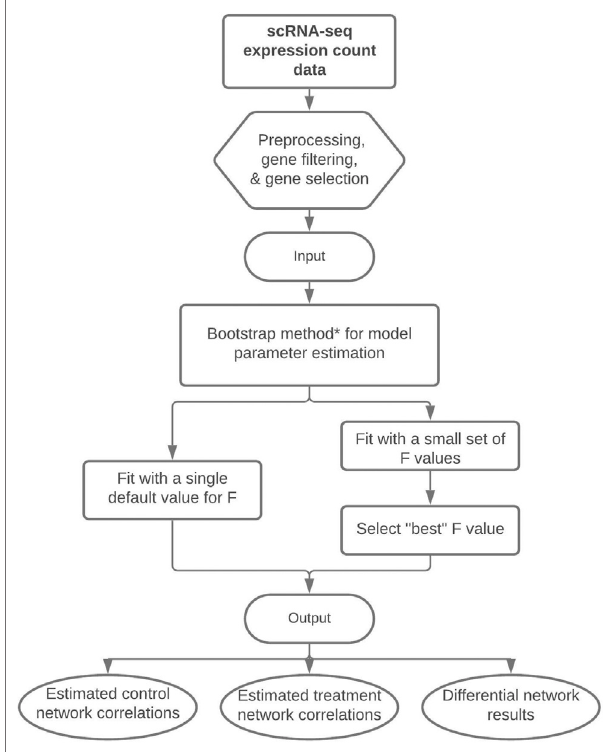
FIGURE 1 | Flowchart of our proposed methodology to perform differential network analysis from scRNA-seq data. The input is a preprocessed scRNA-seq dataset and the output consists of the estimated control and treatment gene-gene correlations and the differential network with signi fi cant gene-gene differences between treatment groups. *Note: The bootstrap method is our recommended technique for model parameter estimation, but parameter estimation could alternatively be performed with a single posterior optimization or via